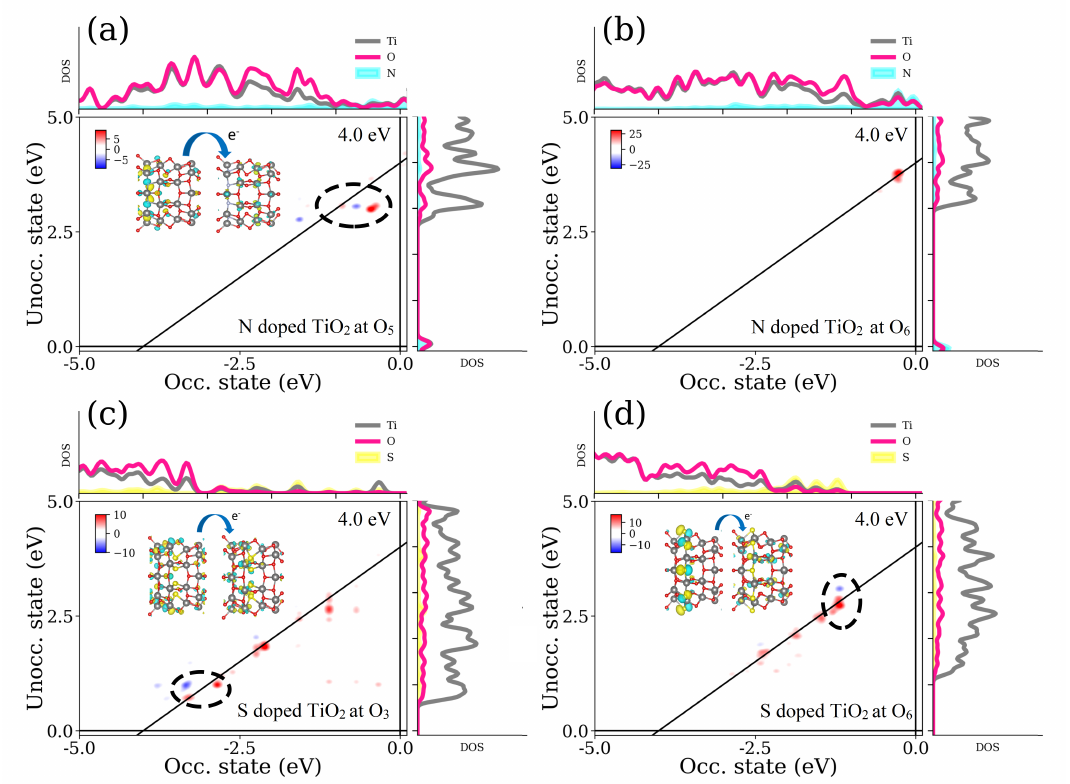
Figure 4. Transition contribution maps (TCM) of N- and S-doped TiO 2 NT. ( a ) N-doped TiO 2 NT at O 5 ; ( b ) N-doped TiO 2 NT at O 6 ; ( c ) S-doped TiO 2 NT at O 3 ; ( d ) S-doped TiO 2 NT at O 6 . The diagonal solid-lines are used to emphasize the constant transition energy of 4.0 eV. DOS includes Ti (grey), O (pink), and dopants (N—cyan and S—yellow) projections. The insets show that orbitals contributed to negative transition (marked by ellipse). The reference energy is set to the Fermi level of each nanostructure separately. Below the Fermi level are occupied states; above the Fermi level are unoccupied states. The color scheme set to elucidate the positive (red) and negative (blue) transition contributions. The color intensity is the ratio between S unocc . occ . ( ω ) and S( ω